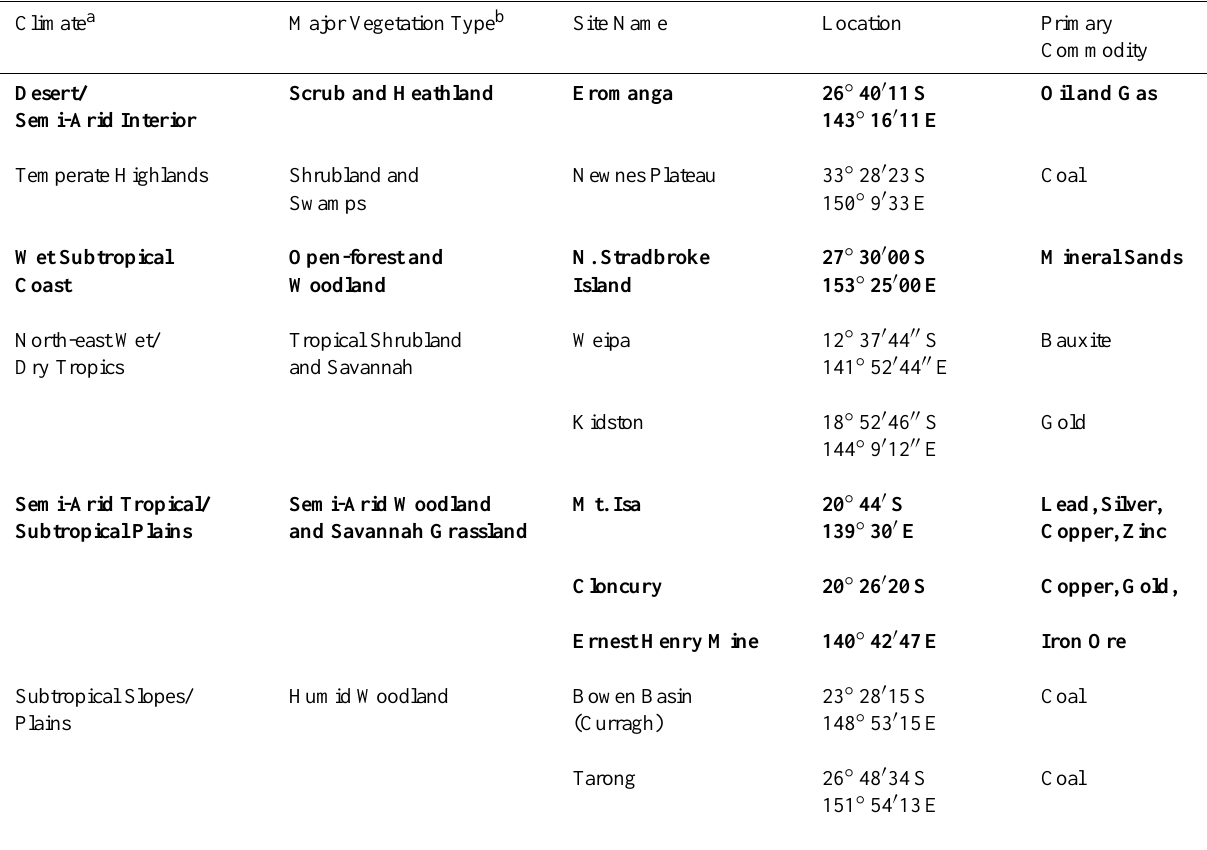
Table 1. Biogeographic characteristics for each post-mining